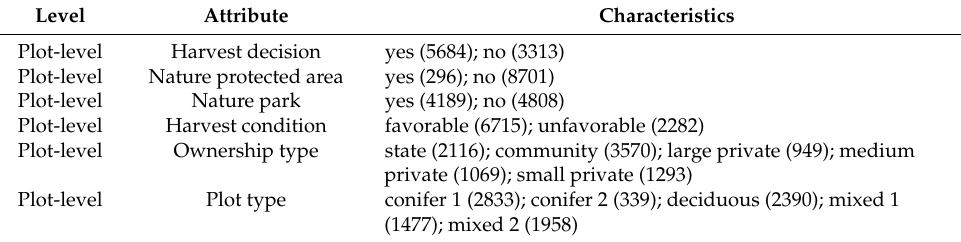
Table A5. Characteristics of discrete variables of training set B (8997